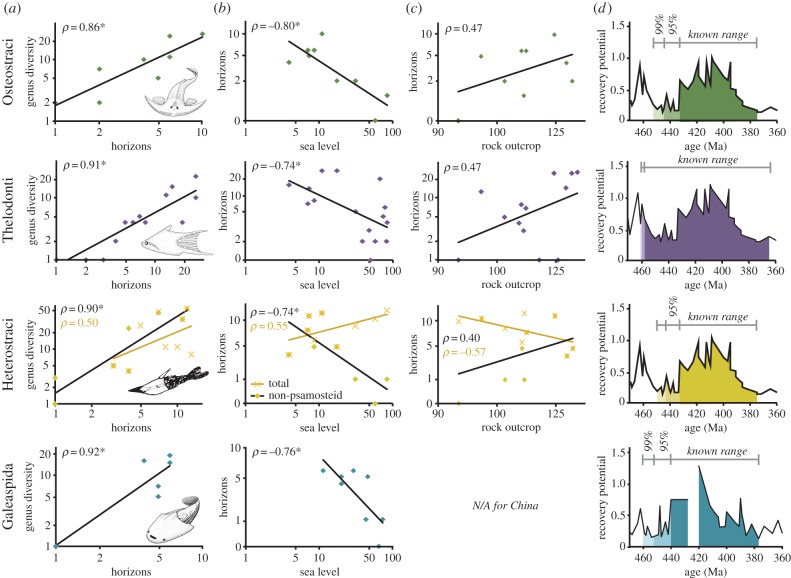
Quantitative assessment of the diversity and recovery potential of the Osteostraci, Thelodonti, Heterostraci (non-psammosteid, yellow/black, and total, orange/brown) and Galeaspida. (a) The positive relationships between diversity (number of genera, without ghost ranges) and record quality (number of horizons); (b) Inverse relationships between the number of horizons per interval and average sea-level per interval (percent maximum); (c) Non-significant correlations between the number of fossiliferous horizons and total rock outcrop area (number of maps of Western Europe from [12]); (d) Fossil recovery potentials through time for Osteostraci, Thelodonti, non-psammosteid Heterostraci and Galeaspisa based upon the inverse logarithmic relationship calculated in (b). The dark area represents the known ranges of the clades (), whilst the lighter (95%) and lightest areas (99%) under the lines represent the confidence intervals calculated as a proportion of the area under the line for the known range . All axes, except time, have been logged. Significant correlations marked with asterisk.